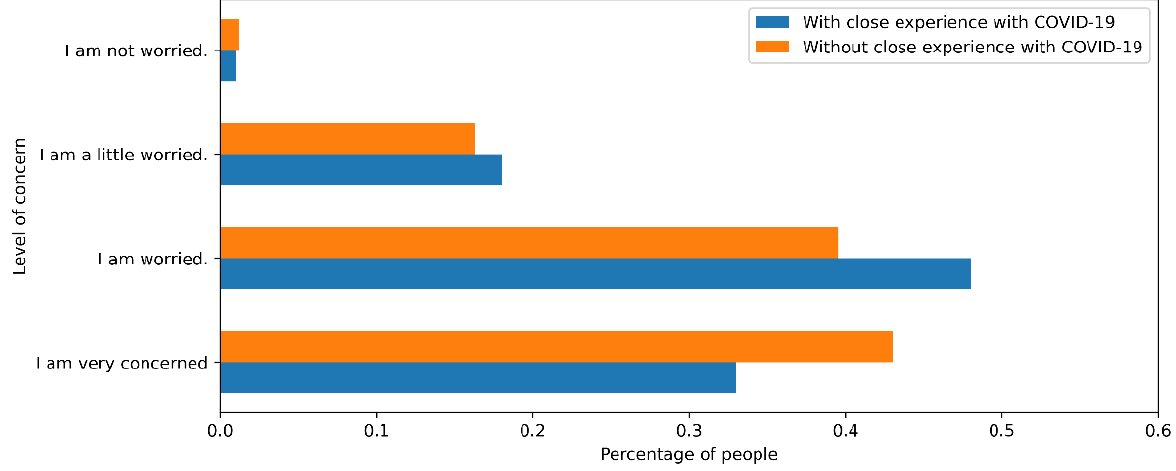
Figure 6. Risk perception based on closeness to COVID-19 cases.